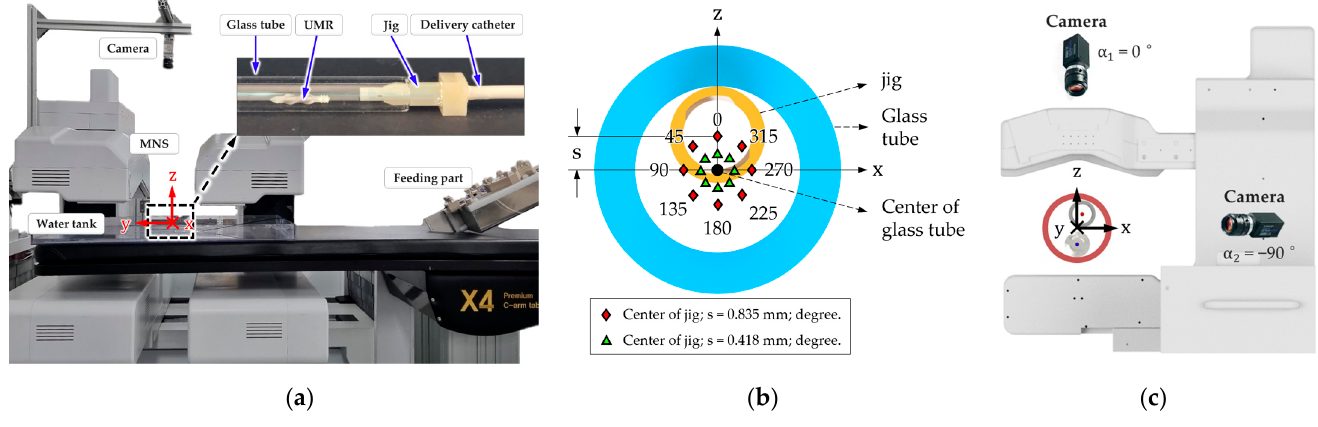
Figure 10. ( a ) Experimental setup for the in vitro experiment on the retrieval process; ( b ) 17 recom- bining positions; ( c ) oblique angle ( α 1 = 0°, α 2 = − 90°) and shooting direction of the RGB